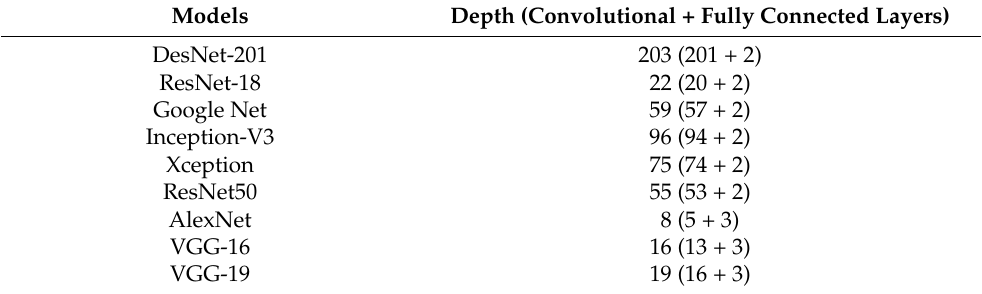
Table 2. Details of deep CNN